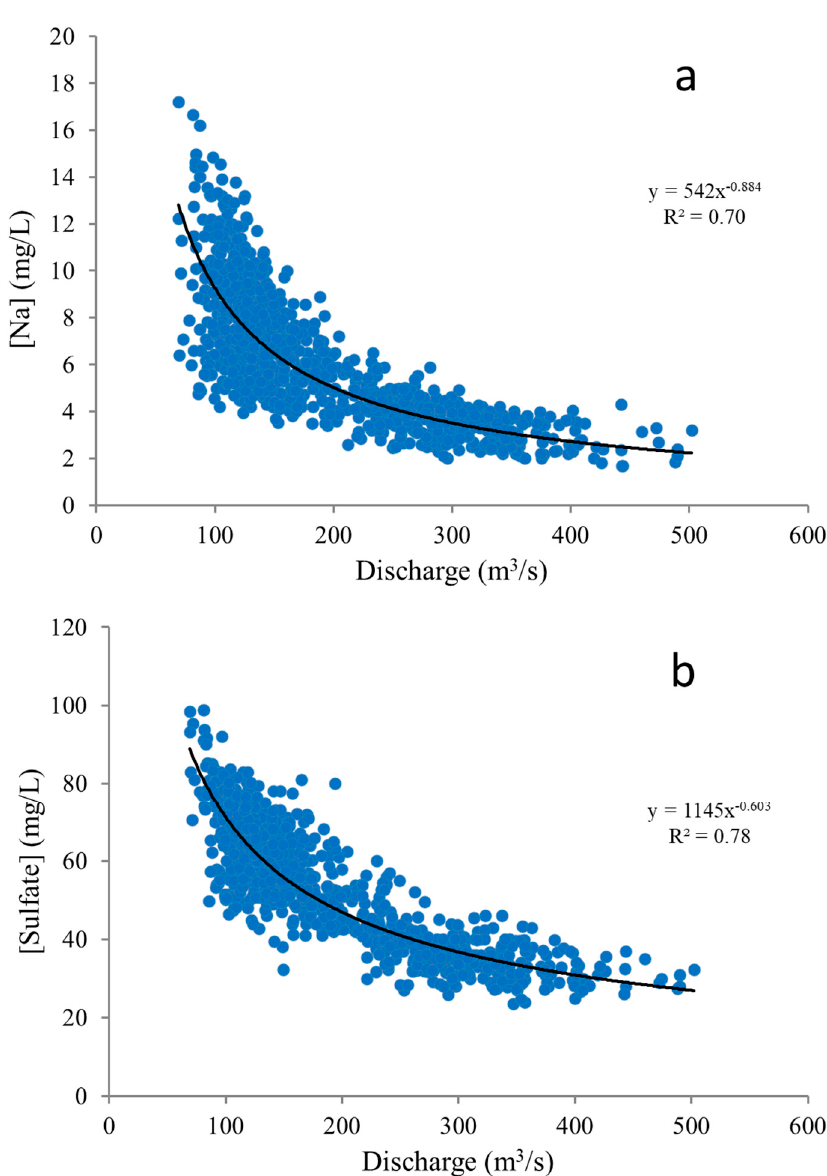
Figure 7. ( a ) Sodium and ( b ) sulfate concentration-discharge relationships.